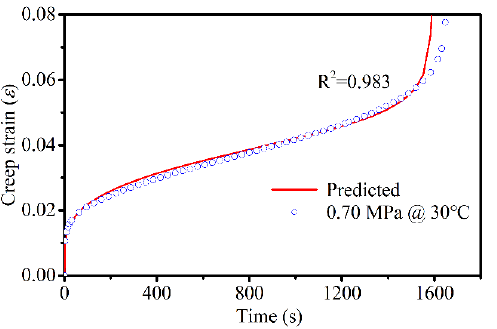
Figure 11. Comparison between the test data of the creep and predicted values at 30 °C and 0.7 MPa.